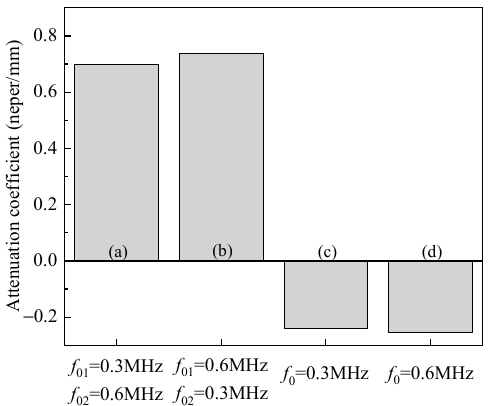
Figure 16. Attenuation coefficients of the composites under broad-band stress waves: ( a ) f 01 = 0.3 MHz, f 02 = 0.6 MHz; ( b ) f 01 = 0.6 MHz, f 02 = 0.3 MHz; ( c ) f 0 = 0.3 MHz; ( d ) f 0 = 0.6 MHz.